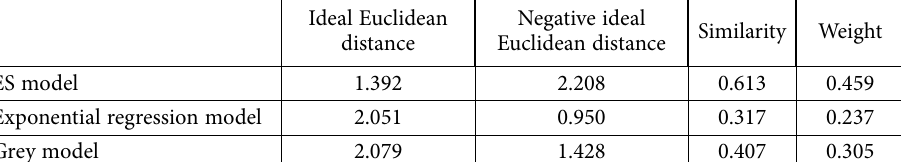
Similarity Weight